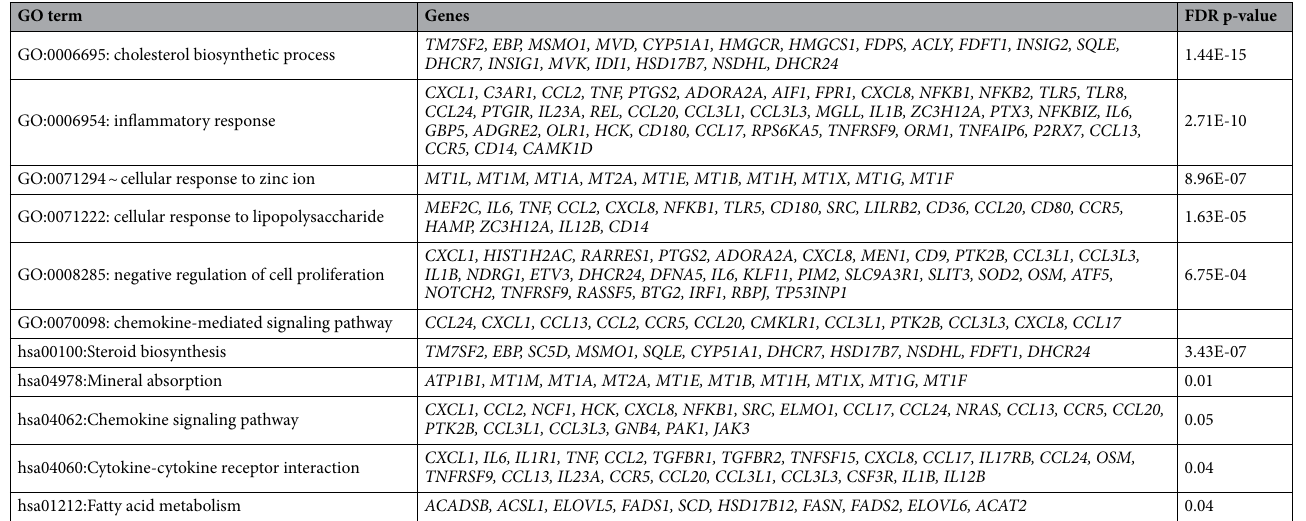
Table 1. Biological processes down regulated in mDCs treated with EVs when compared with untreated mDCs. The p value was FDR corrected.